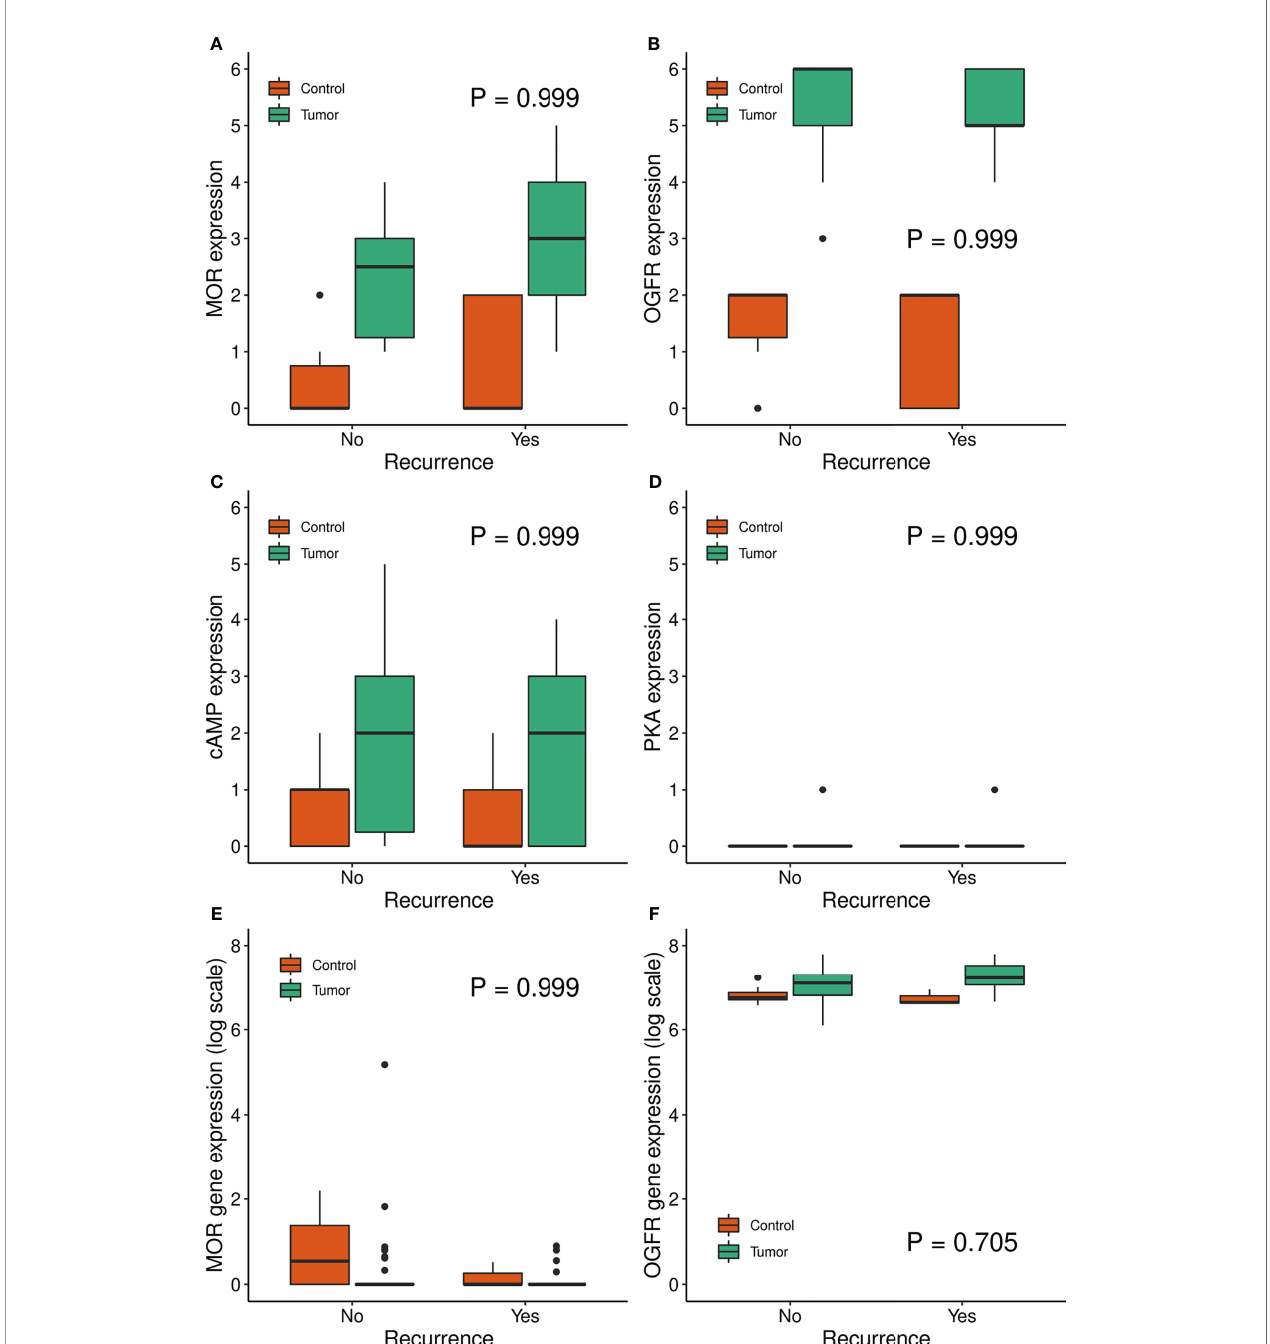
FIGURE 4 | Boxplot of MOR, OGFR, cAMP, PKA expression by recurrence group. Panels (A – D) show results from IHC staining from the nested matched case- control sample. Panels (E, F) show gene expression from the TCGA and GTEx